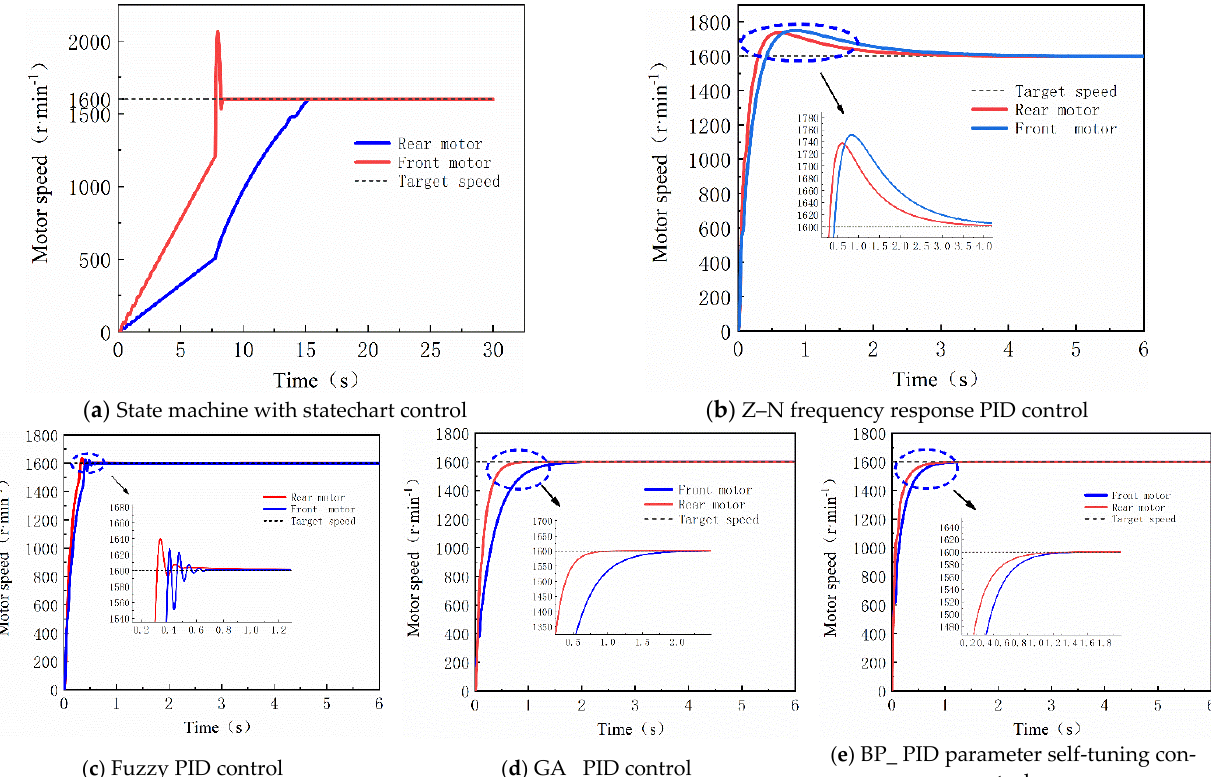
Figure 18. Design of adaptive tracking controller.